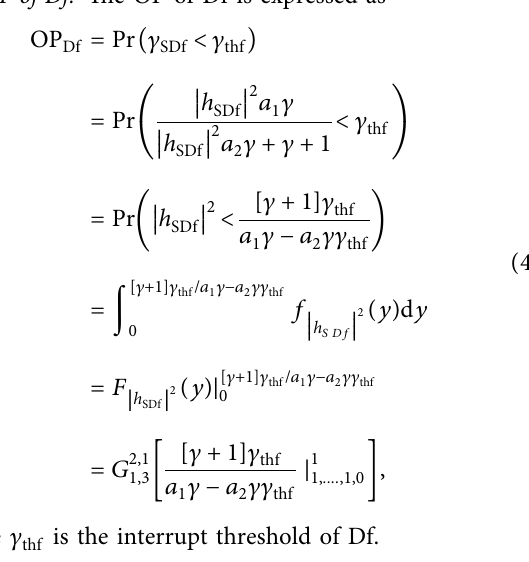
Figure 1 is the mobile NOMA communication system. The system is composed of a source S, a far user Df, and a near user Dn. h represents the channel gains of S ⟶ Df and S i